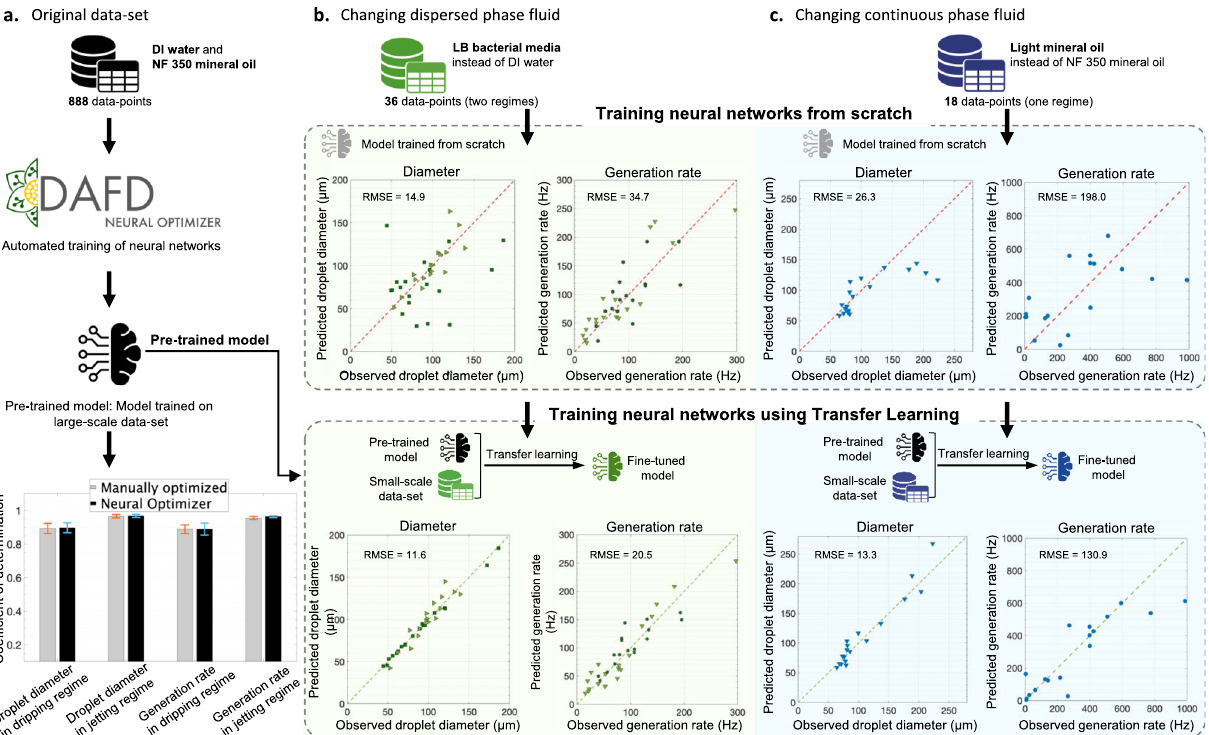
Fig. 5 Generalizing performance prediction to new fl uid combinations. a Large-scale data-sets on any fl uid combinations can be uploaded to DAFD Neural Optimizer to generate optimized neural networks without requiring extensive machine learning expertise, with comparable accuracy to models manually optimized. Error bars represent two standard deviations calculated based on ten different training and testing sessions where the test-set and train-set were randomly chosen. b For a small-scale data-set on LB bacterial cell media (instead of DI water) and NF 350 mineral oil, training neural networks from scratch resulted in inaccurate models. However, transfer learning signi fi cantly improved the accuracy of models on the same data-set. c For a small-scale data-set on DI water and light mineral oil (instead of NF 350 mineral oil), training neural networks from scratch resulted in inaccurate models. Using transfer learning the accuracy of the trained neural networks was improved signi fi cantly, despite the large difference in continuous phase fl uid properties. Therefore, the pre-trained models on DI water and NF 350 mineral oil and transfer learning can be used to extend DAFD without requiring large-scale